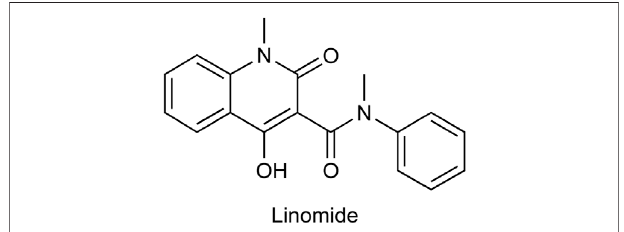
Frontiers in Pharmacology |